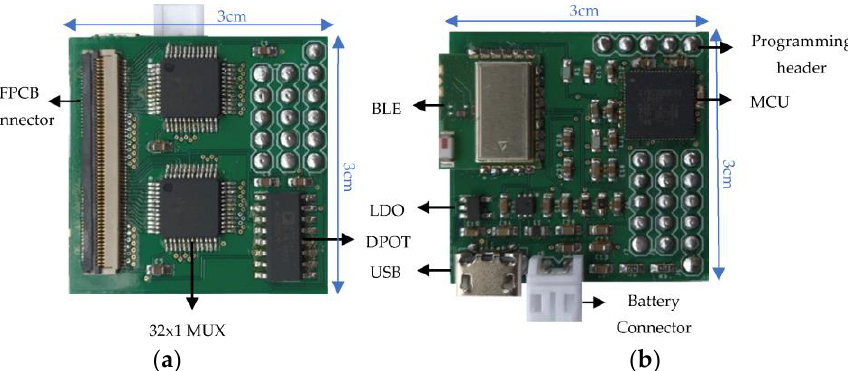
Figure 3. ( a ) Assembled top printed circuit board (PCB) with labelled parts (3 cm × 3 cm × 0.2 mm); ( b ) assembled bottom PCB with labelled parts (3 cm × 3 cm × 0.2 mm).